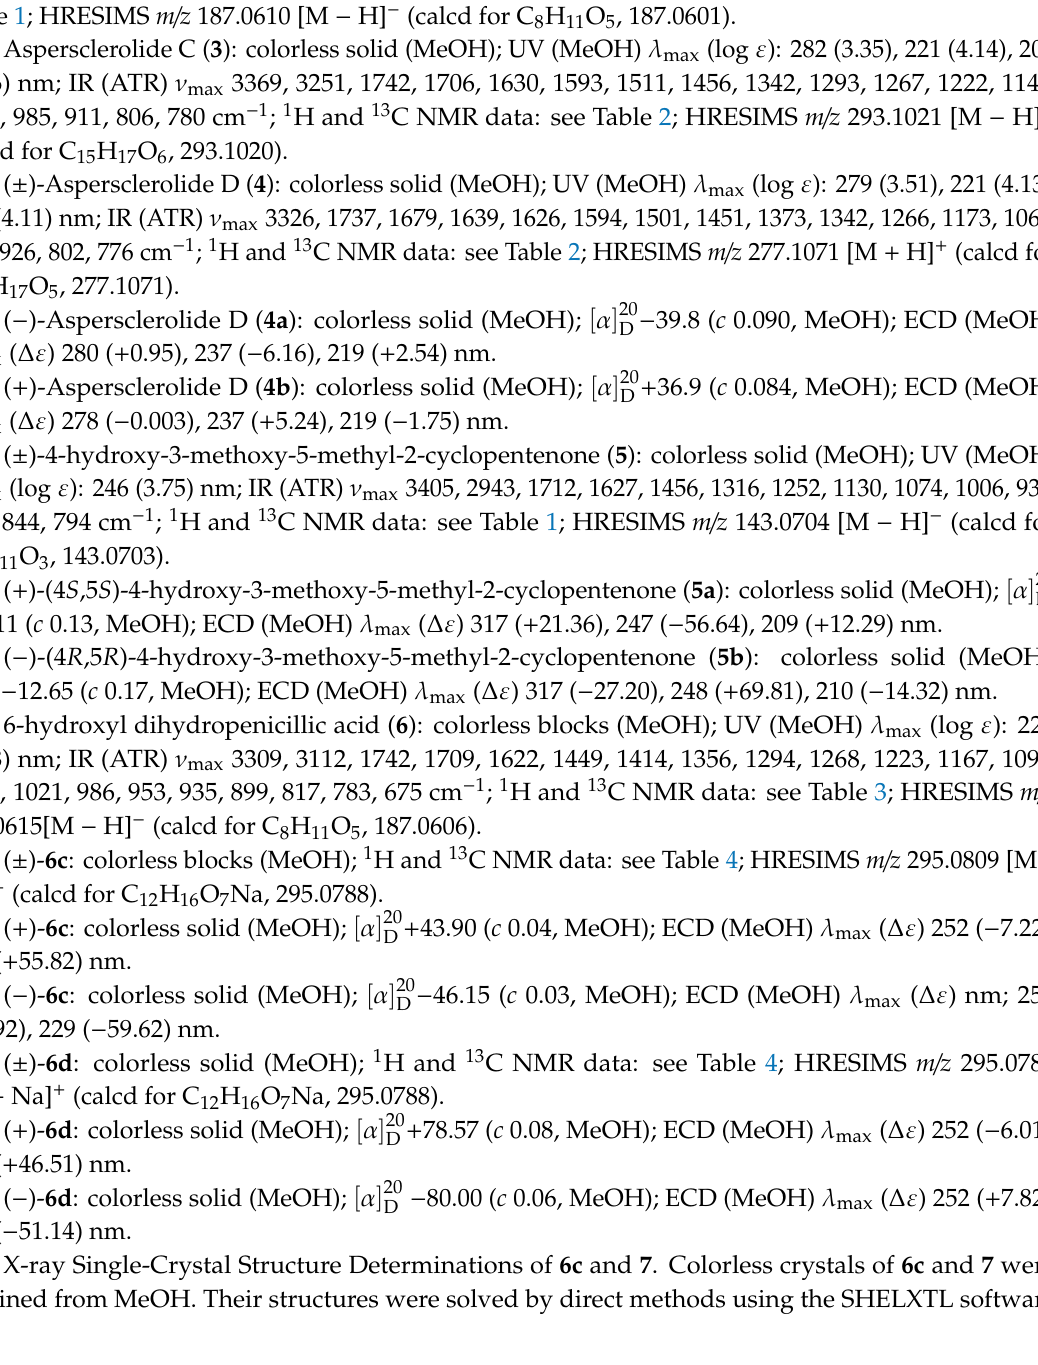
− (calcd for C 8 H 11 O 5 ,